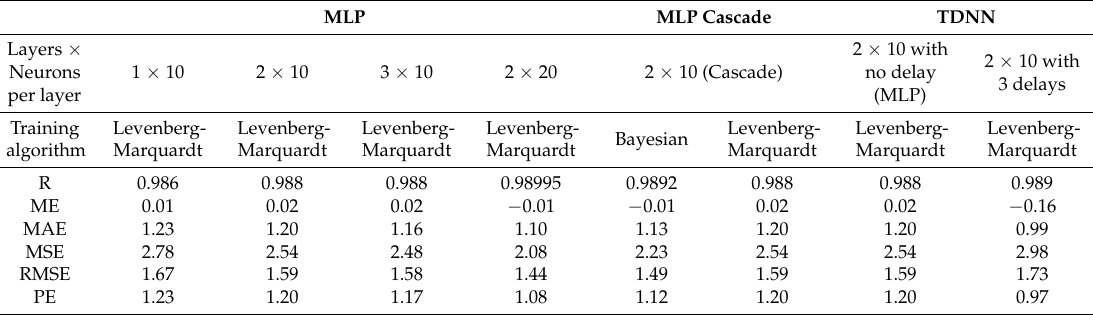
Table 2. Results obtained for the experiments by specific model net configuration.